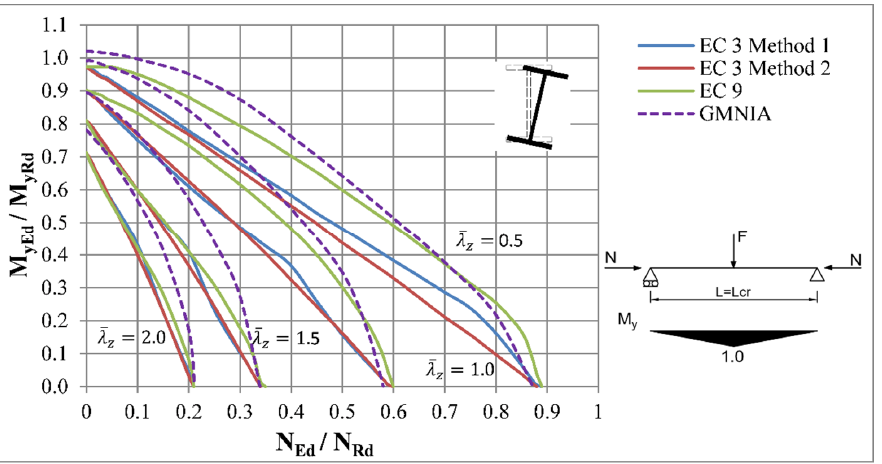
Figure 17. Interaction curves for laterally unrestrained beam-columns with IPE 100 cross-section with restrained warping.